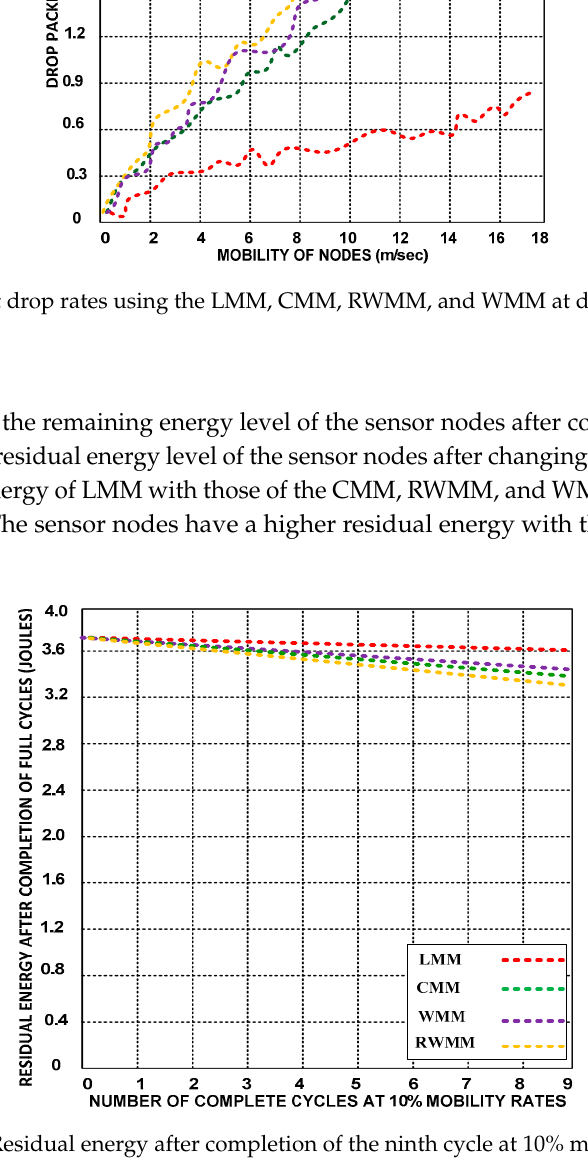
Figure 11. Residual energy after completion of the ninth cycle at 10% mobility rates.